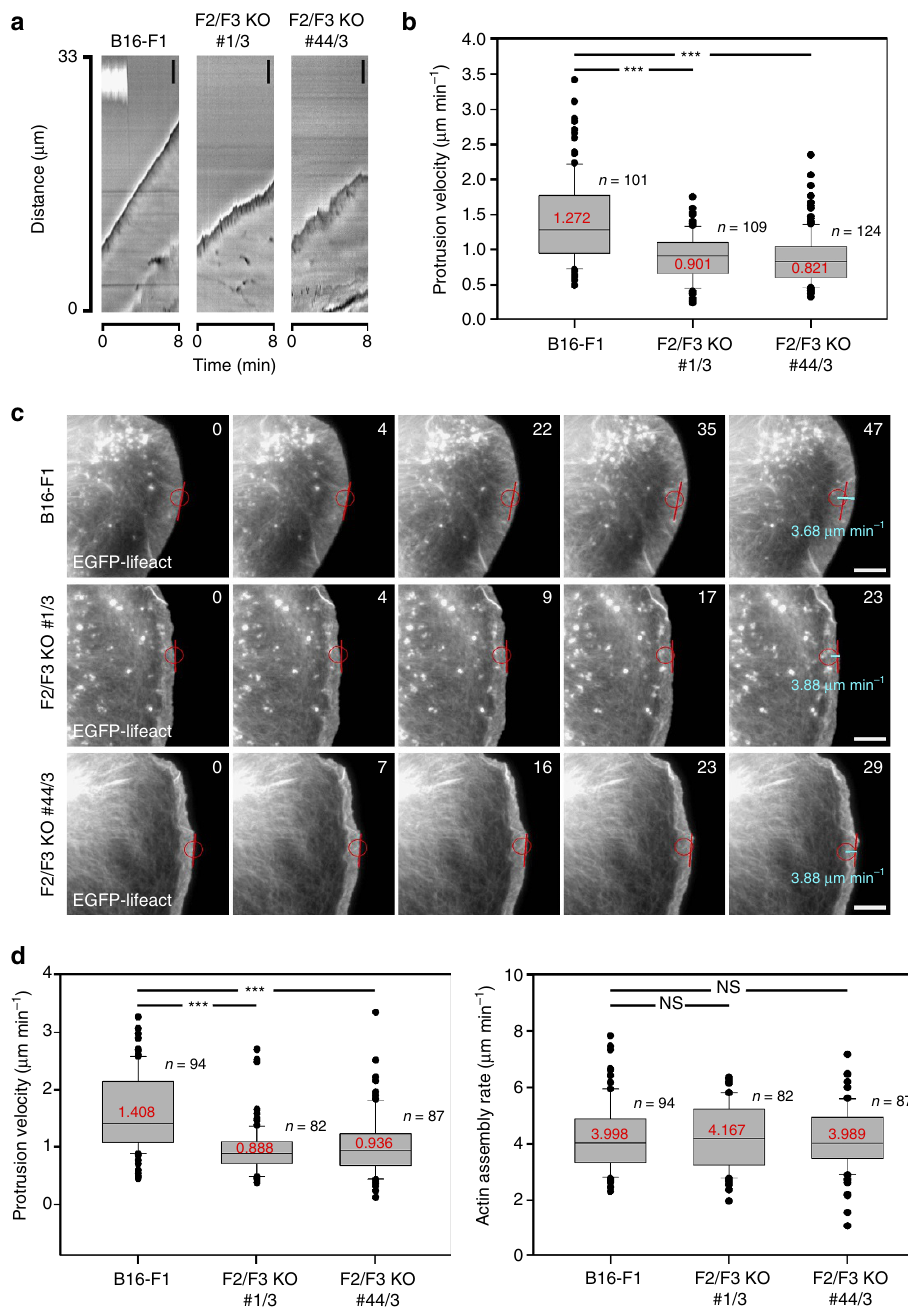
Figure 5 | Reduced protrusion in FMNL2/3 KO is not caused by decreased network polymerization. ( a ) Representative kymographs demonstrating lamellipodial protrusion of FMNL2/3 knockout cells compared to B16 controls. Note that protrusion in case of F2/F3 KO#1/3 and F2/F3 KO#44/3 is much less smooth as usually seen with control B16 (left panel). Bars equal 3 m m. ( b ) Box and whiskers plots depicting average protrusion velocity ( m m min (cid:2) 1 ). Red numbers denote medians of respective data sets; n gives the number of cells analysed. ( c ) Time-lapse frames of B16 and respective FMNL2/3 KO clones transfected with EGFP-lifeact. Images show sections of respective lamellipodia before and during tracking of fluorescence inhomogeneities performed to determine lamellipodial actin assembly rates; for experimental detail, also see legend to Supplementary Fig. 8c. Time is in seconds, bars equal 5 m m. ( d ) Average protrusion velocities (left panel) or actin assembly rates (right panel) of respective cell types expressing EGFP-lifeact. Box and whiskers plots are as shown in b . In spite of significant reduction of average protrusion velocities in FMNL2/3 KO lines (left panel), the rate of lamellipodial actin assembly is almost identical (right panel). *** p o 0.001 by Mann–Whitney rank sum